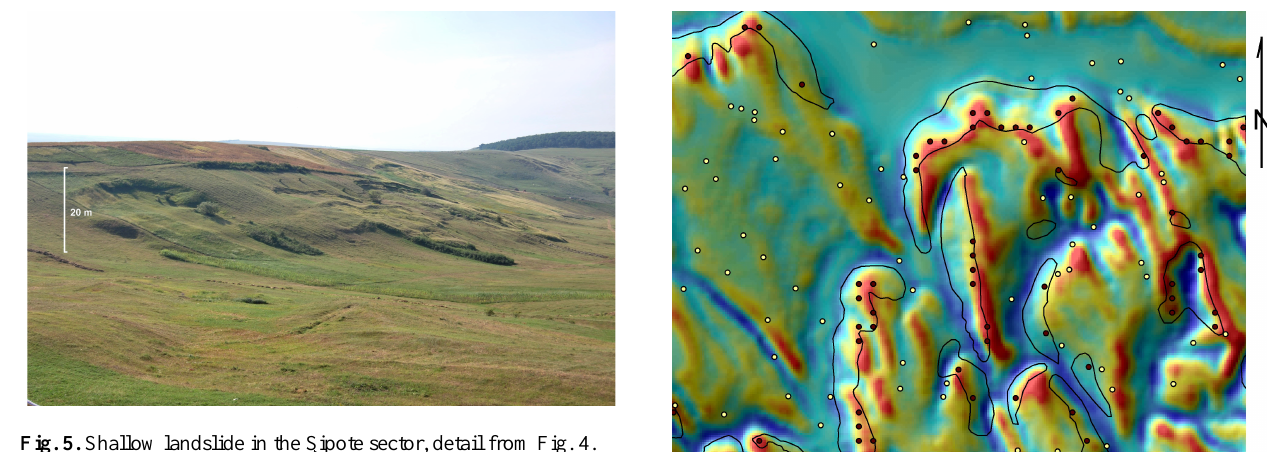
Fig. 5. Shallow landslide in the ¸Sipote sector, detail from Fig. 4.